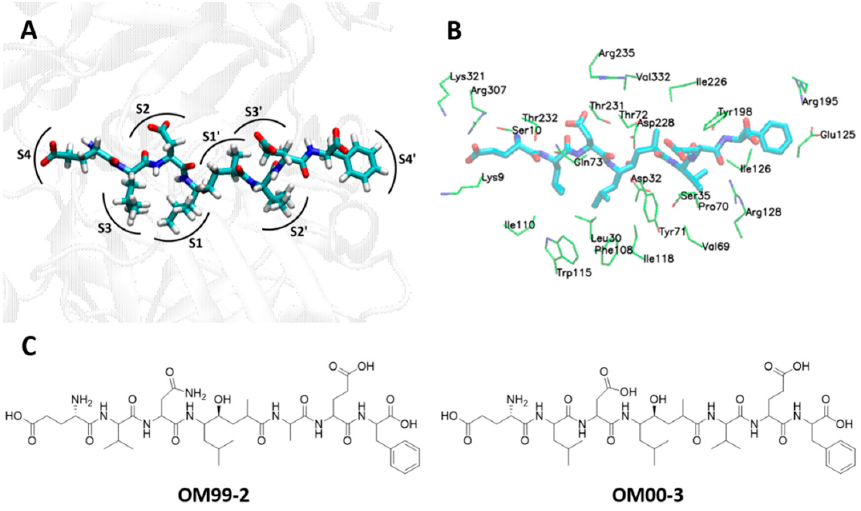
Figure 3. The active site of BACE1 and its inhibitors. ( A ) The subsites of BACE1 active site, ( B ) residues of BACE1 subsites interacting with OM00-3 inhibitor (PDB ID: 1M4H), and ( C ) 2D structures of OM99-2 and OM00-3 inhibitors.